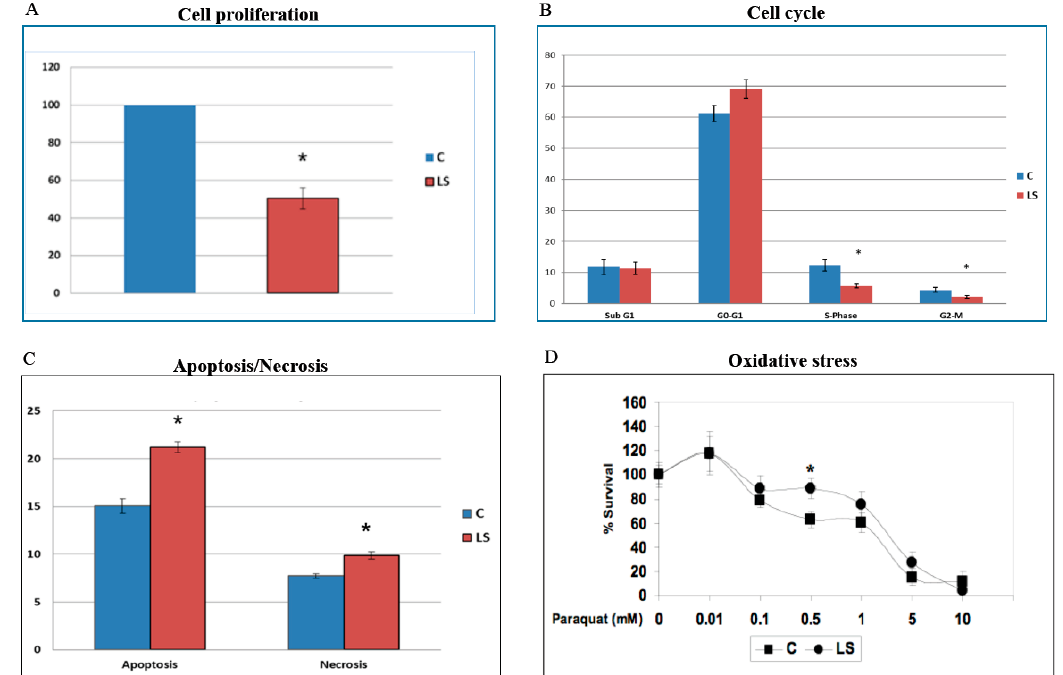
(v) Is autophagic machinery involved in cancer evasion in LS? XTT colorimetric assays revealed that the proliferation rate of LS-derived lymphoblastoid cells was reduced by 50% (Figure 3A) [67]. Cell cycle analyses showed that the proportion of cells in the G2-M phase in response to etoposide (a DNA-damaging agent) in LS was reduced by 50% in comparison to controls (2.2% in LS compared to 4.4% in control cells). Similarly, the proportion of LS cells in S phase was reduced in comparison to healthy cells. Combined, the data indicate that the response of LS cells to DNA damage in terms of cell cycle progression was attenuated (Figure 3B). Along the same lines, flow cytometry indicate that the percentage of apoptotic cells under basal conditions was 40% higher in LS compared to controls (Figure 3C). Likewise, the percentage of necrotic cells was increased by 27% in LS.